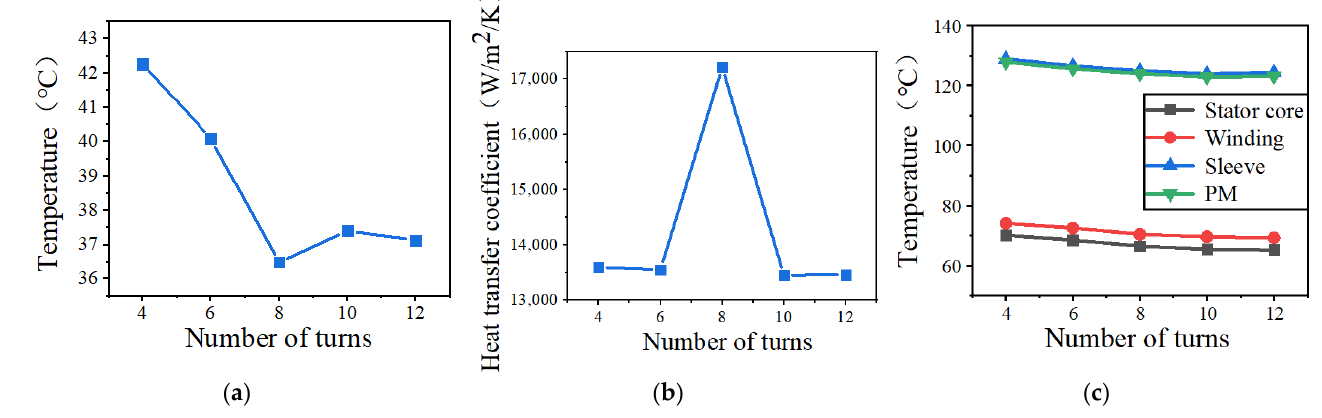
Figure 15. Thermal analysis results of HSPMMs with different number of cooling channel turns. ( a ) Cooling water maximum temperature; ( b ) Heat transfer coefficient; ( c ) Motor maximum tempera-